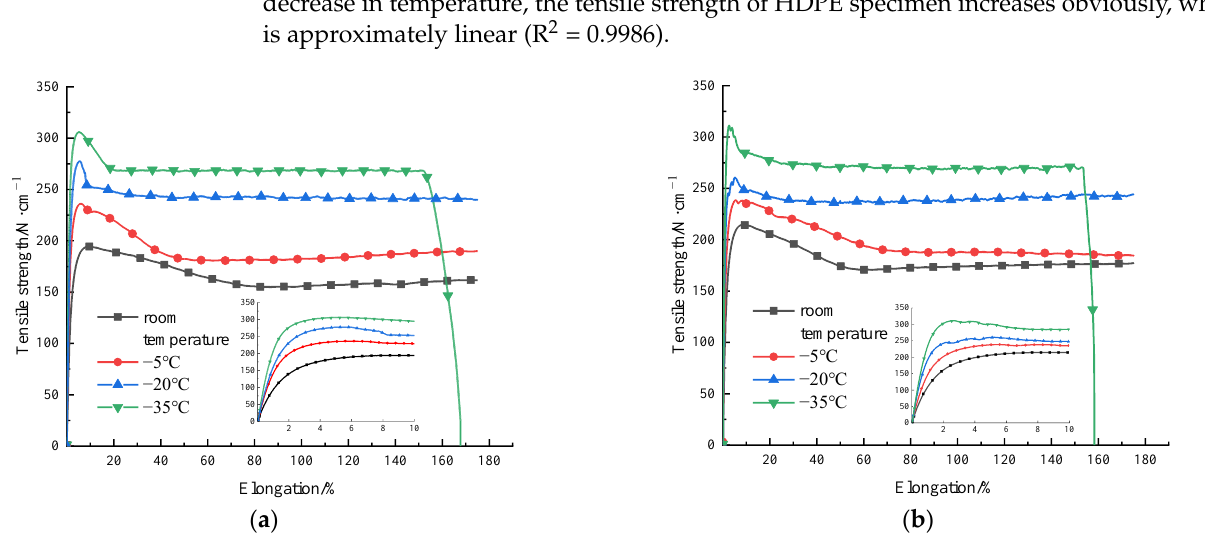
Figure 3. Tension curves of HDPE specimens I ( a ) and II ( b ) respectively at different temperatures. (Note: The small figure shows the detail of the first 10% elongation of the tension curves of HDPE specimens).